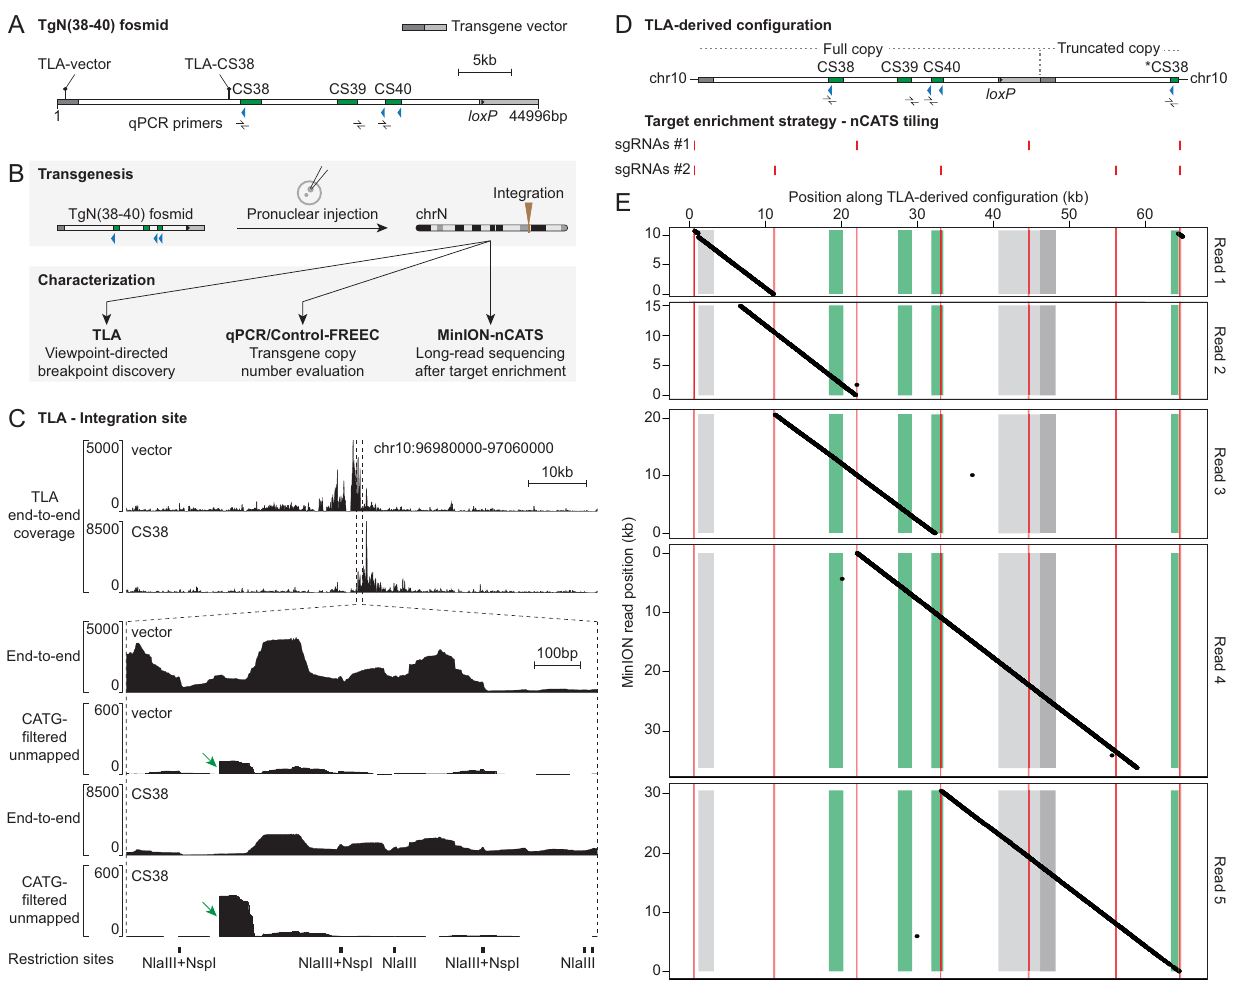
Fig 2. Characterization of the TgN(38–40) integration. (A) Schematic representation of the TgN(38–40) fosmid, vector in gray. Position of TLA viewpoints (lollipops) and qPCR primers (left to right: CS38, CS39 and CS40a) is indicated. (B) Transgenesis and characterization workflow. (C) Analysis of the TgN(38–40) integration by TLA. Top, TLA end-to-end coverage around the candidate integration site. Bottom, magnification of the above-mentioned area. Both end-to-end and CATG-filtered unmapped coverages are shown. Green arrows highlight sharp drops in the CATG-filtered unmapped signal. TLA restriction sites are shown below. (D) Top, TLA-derived genomic configuration. Asterisk, second partial CS38 element. Bottom, position of the two distinct pools of sgRNAs used for nCATS. (E) Analysis of the TgN(38–40) integration using MinION-nCATS. Dot plot representation of five selected MinION reads (ranging from 10 to 35 kb) along the TLA-derived configuration (horizontal axis), color-coded as in (D). The ~600 bp duplication of chromosome 10 sequence manifests as a subtle discontinuity in read 1 on the left as well as a small diagonal on the right.